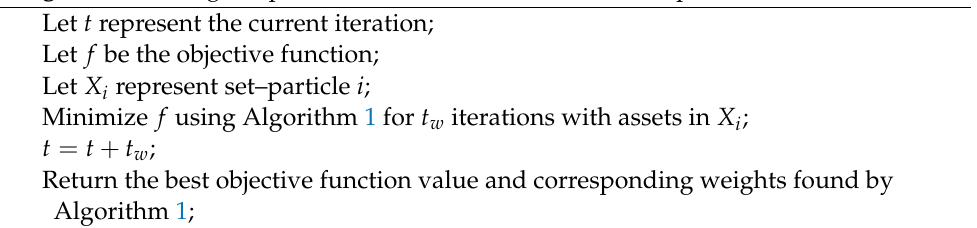
Algorithm 2: Weight Optimization for Set-Based Portfolio Optimization